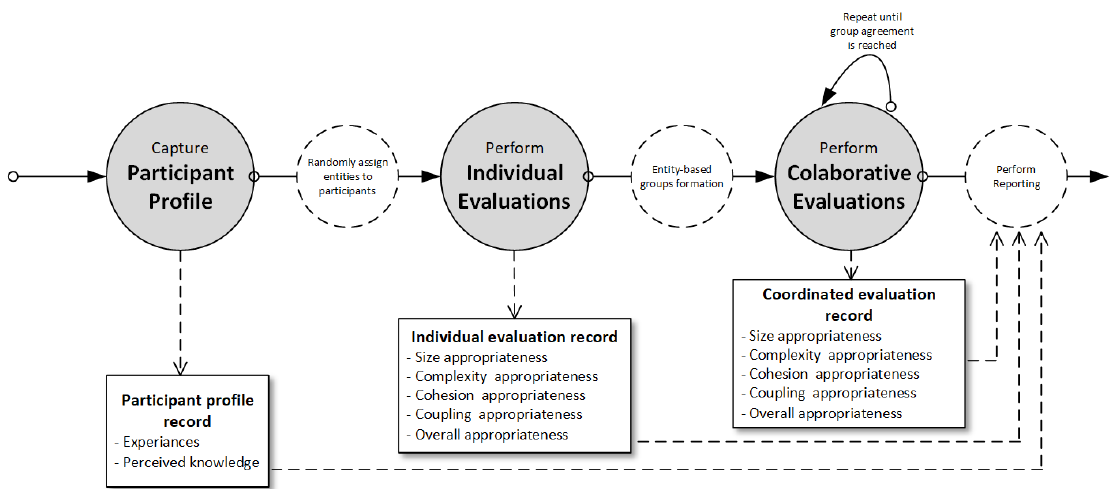
Figure 2. The experiment process—the experiment was executed for students and professionals separated.